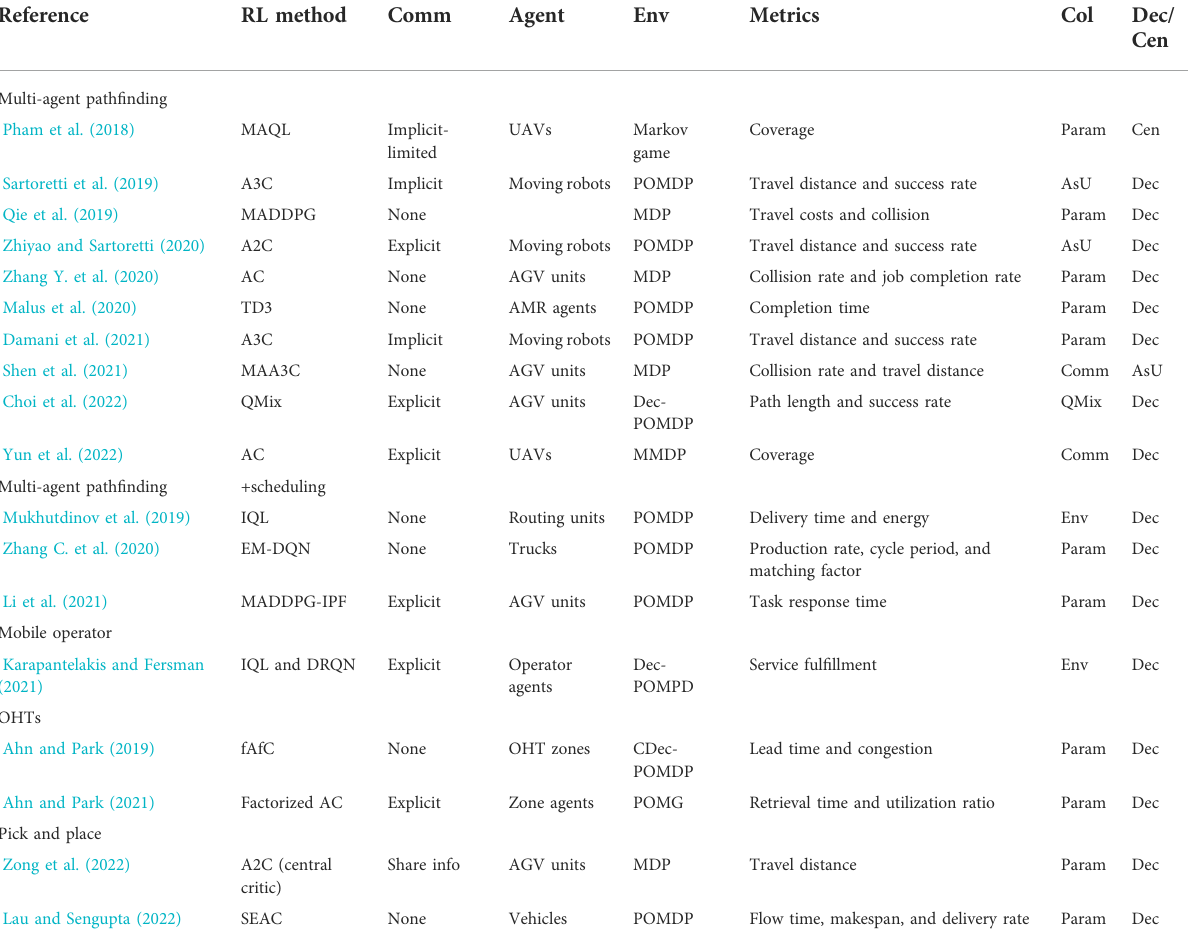
TABLE 2 Comparison between the applications of MARL to transportation tasks in smart